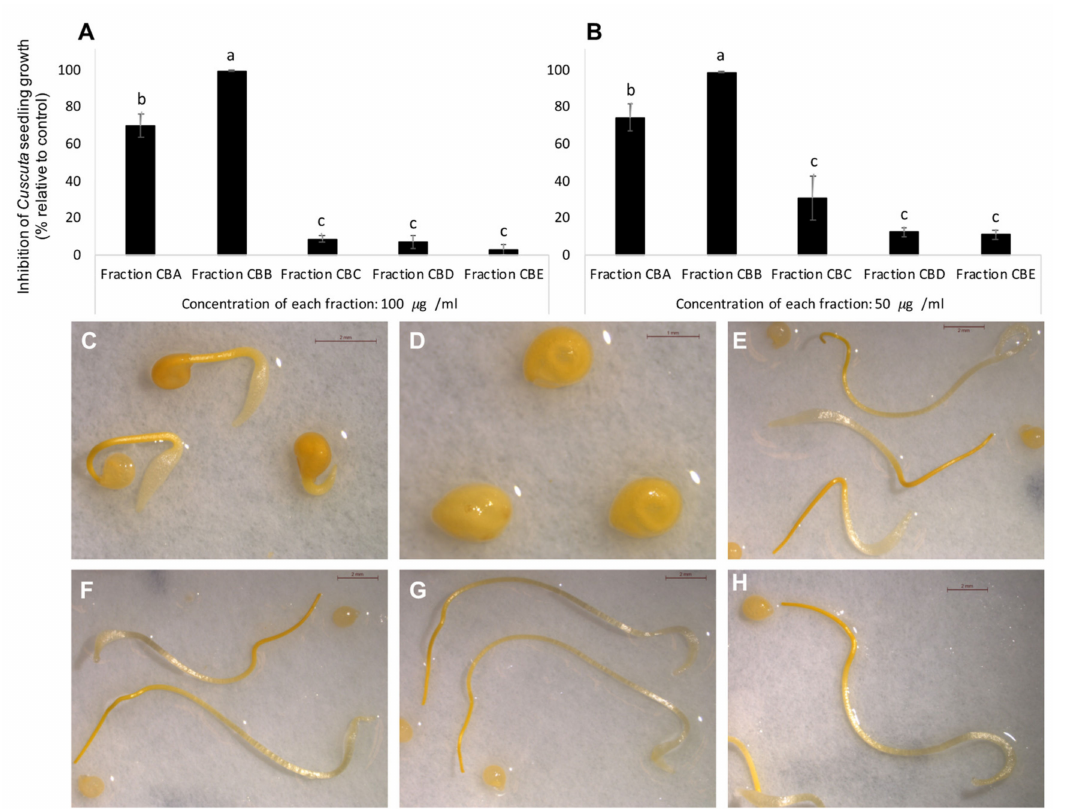
Figure 5. Allelopathic effects of five homogeneous fractions obtained from Conyza bonarien- sis dichloromethane extract on growth of six day-old Cuscuta campestris seedlings applied at ( A ) 100 µ g/mL and ( B ) 50 µ g/mL. ( C – H ) Photographs illustrating the development of Conyza seedlings when treated with: ( C ) C. bonariensis first fraction CBA; ( D ) C. bonariensis second frac- tion CBB; ( E ) C. bonariensis third fraction CBC; ( F ) C. bonariensis fourth fraction CBD; ( G ) C. bonariensis are significantly different using the Tukey test ( p = 0.05). Error bars represent the standard error of the mean.